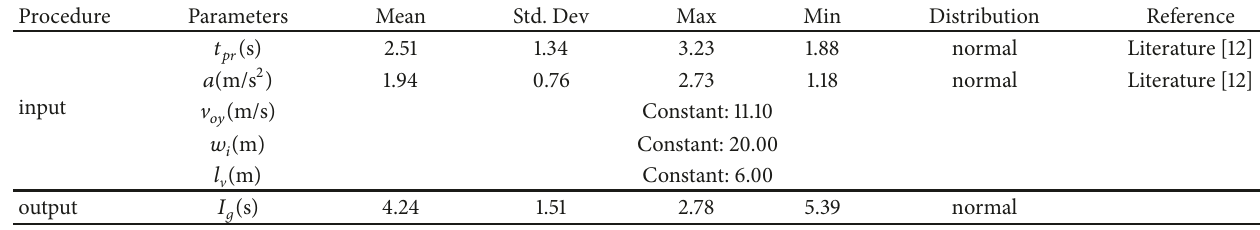
Table 2: The input and output data of the Monte-Carlo simulation.